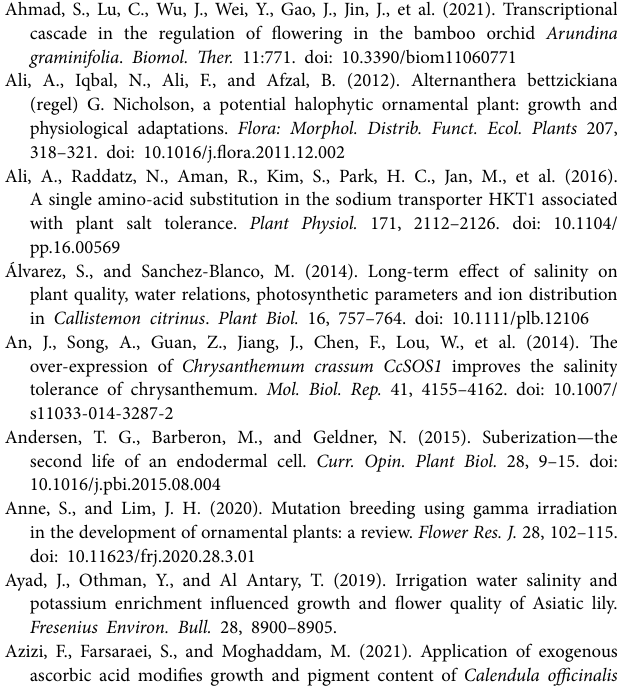
Supplementary Figure S1 | Summarized structural adaptation to salinity of halophytic ornamental plants. Notes: (i) pumping Na + back to the environment; (ii) depositing large amounts of salt ions in vacuoles of succulent tissues; (iii) secreting salt ions through salt bladder; (iv) secreting salt ions through salt